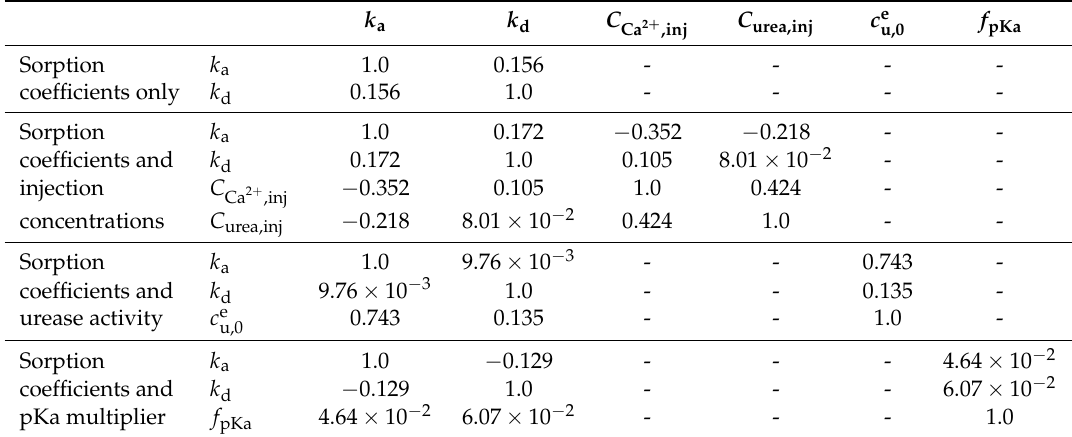
Table 2. Parameter correlations as given by the PEST protocol [58] for the four investigated sets of calibration parameters calibrating to the concentration measurements of column #1 (0.33